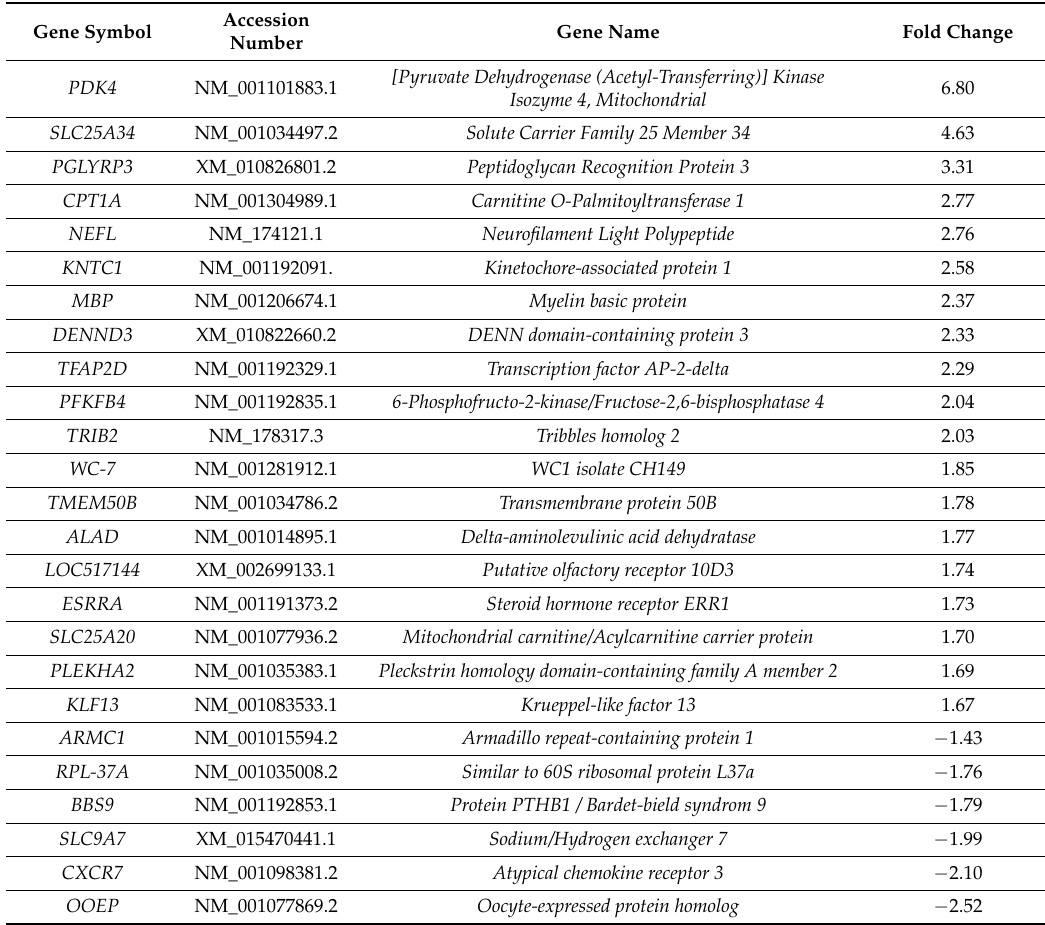
Table 1. Differentially expressed genes (alphabetic classification) in MG of early lactation Holstein cows in response to undernutrition and intra-mammary lipopolysaccharide (LPS) challenge. Transcriptomic comparison of control (CONT; n = 6) and restricted diet (REST; n = 6). Normalized microarray data were analyzed using GeneSpring software and moderated t -tests with Westfall–Young